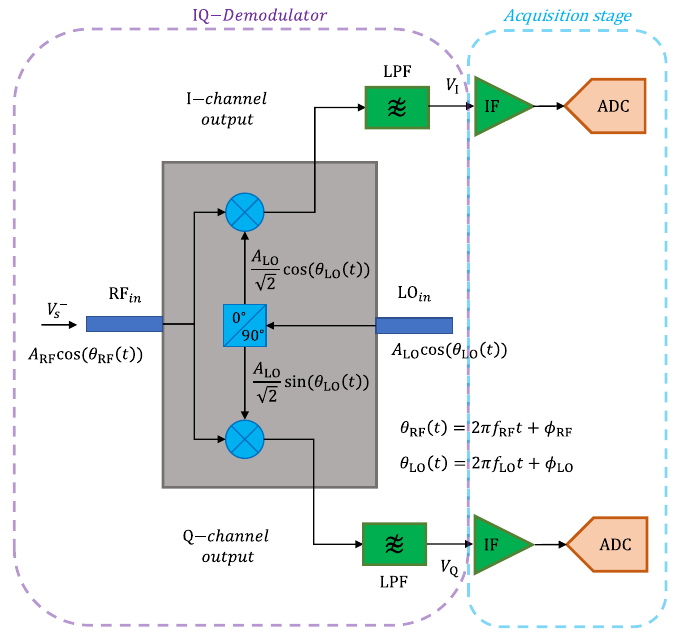
Figure 11. Schematic of the comparison and data acquisition stages.